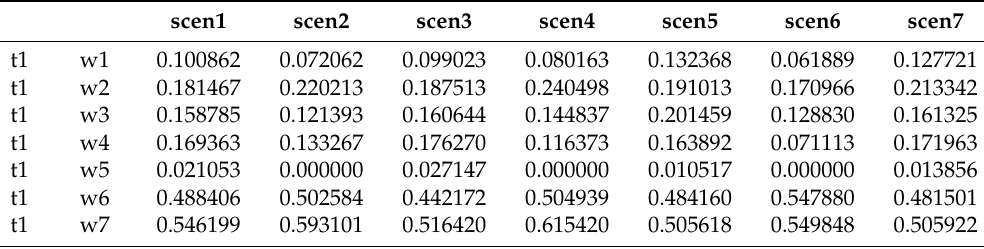
Table A25. Probability for each scenario for each wind unit: wind_scenarios_1( t , w